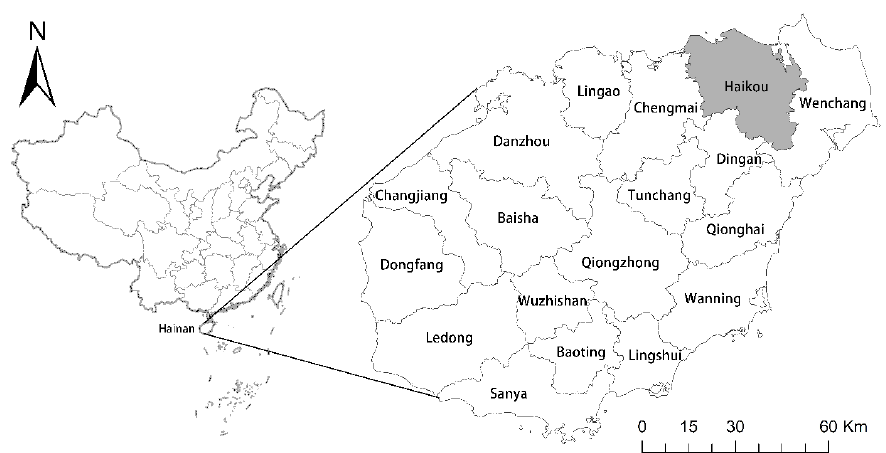
Figure 1. A map of the study area.